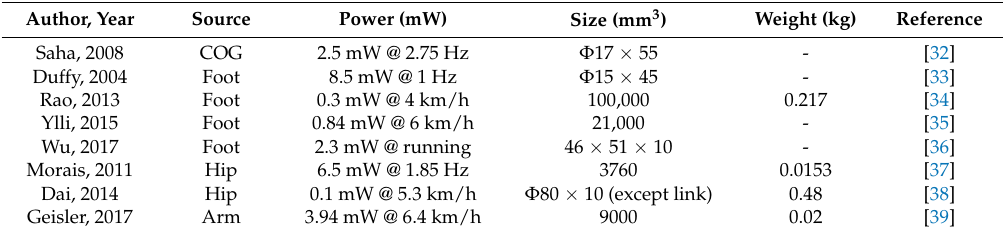
Table 4. Wearable electromagnetic energy harvesters (inertial induction).